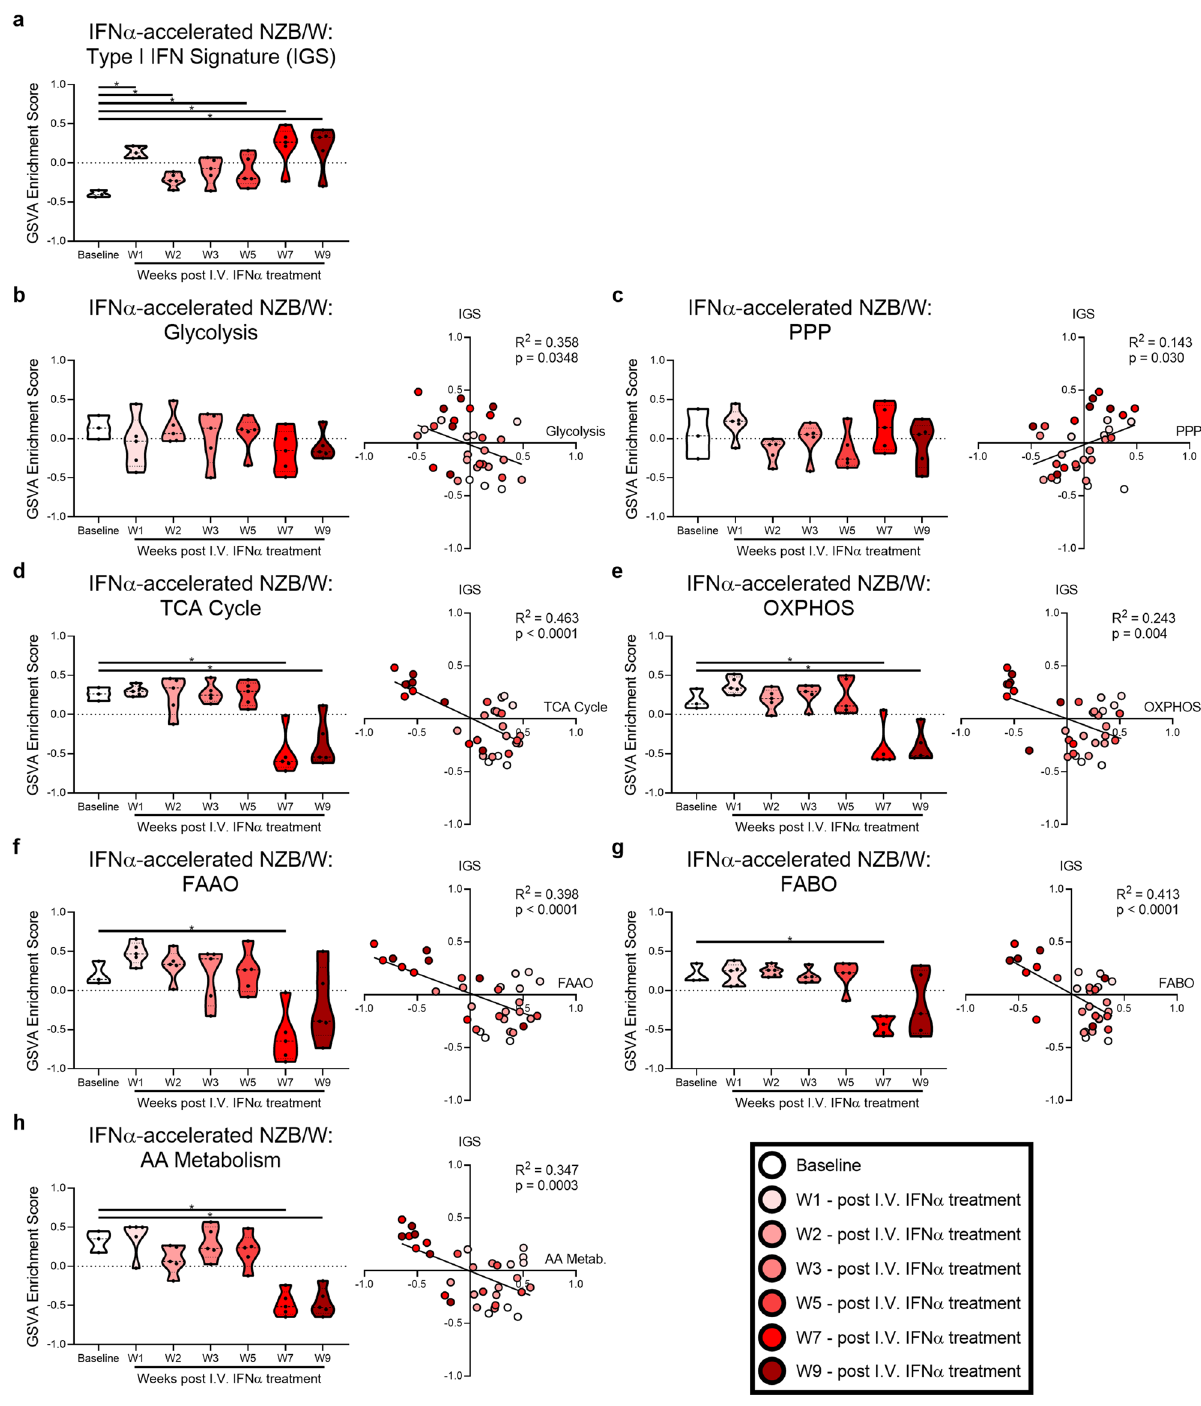
Figure 6. Metabolic gene expression changes occur independent of acute IFN stimulation in murine LN. GSVA of ( a ) the IGS in the kidney of IFNα-accelerated NZB/W mice (GSE86423). ( b – h ) GSVA of metabolic signatures and linear regression between the IGS and metabolic signature GSVA scores. Each point represents an individual mouse. For each signature, significant differences in enrichment at each timepoint compared to baseline were evaluated with the Mann–Whitney U test. For all calculations the following sample numbers were used: Baseline (n = 3), W1 (n = 5), W2 (n = 5), W3 (n = 5), W5 (n = 5), W7 (n = 5), and W9 (n = 5). Significant p-values in the regression plots in ( b – h ) reflect significantly non-zero slopes. *, p < 0.05; **, p < 0.01; ***, p < 0.001; ****, p <